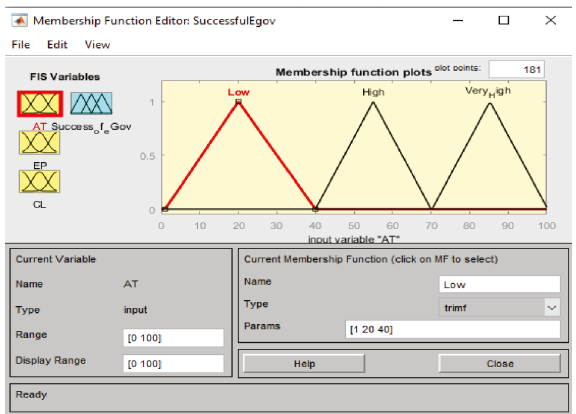
Figure 3: Fuzzification for IAT.